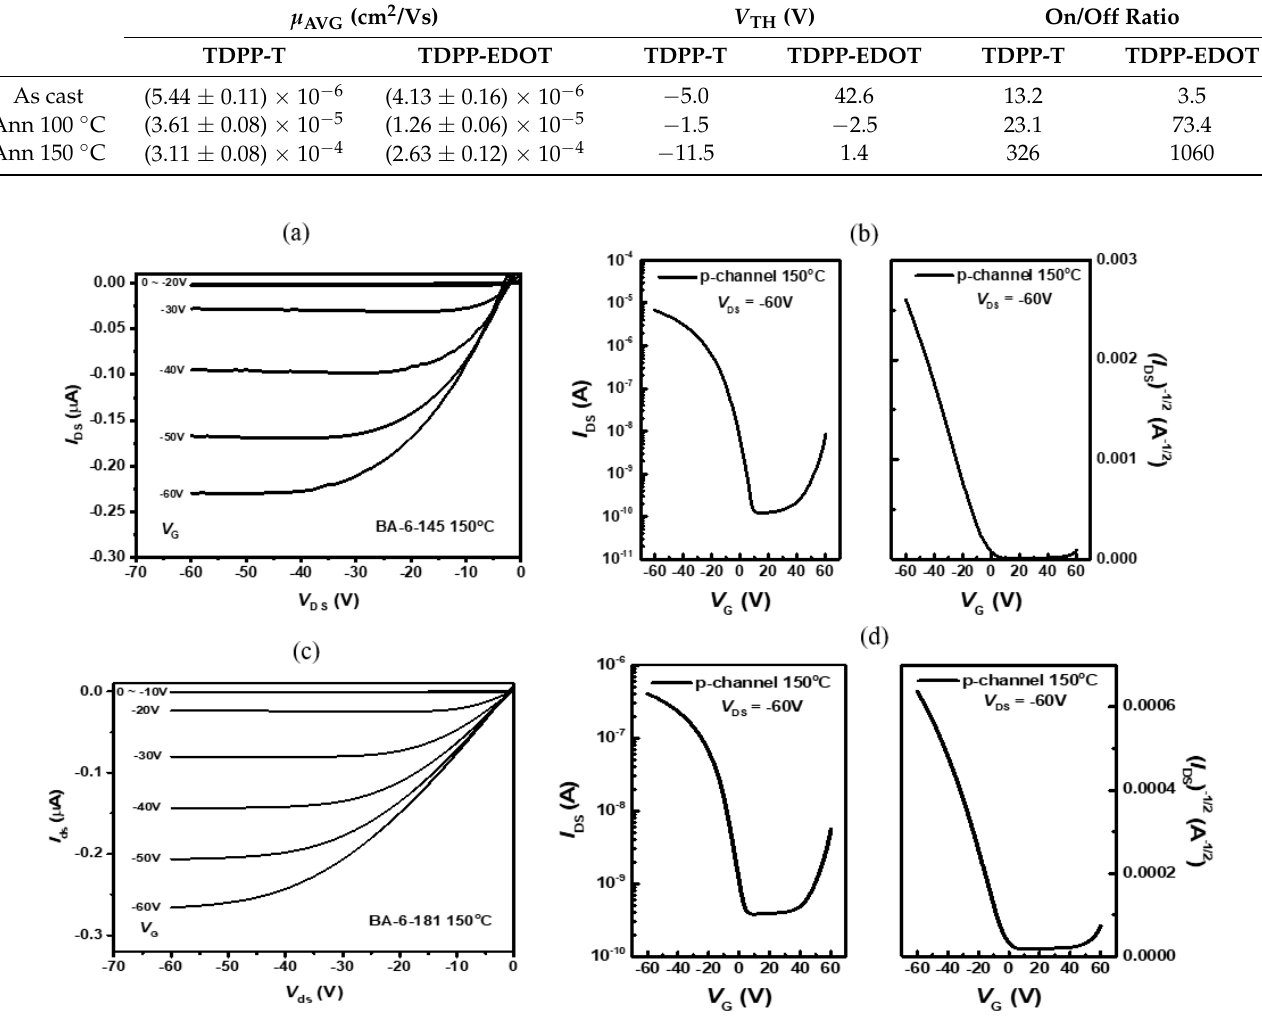
Figure 4. OTFT field-effect transistor characteristics. Output curves of ( a ) TDPP-T and ( c ) TDPP-EDOT . Transfer curves of ( b ) TDPP-T and ( d ) TDPP-EDOT .